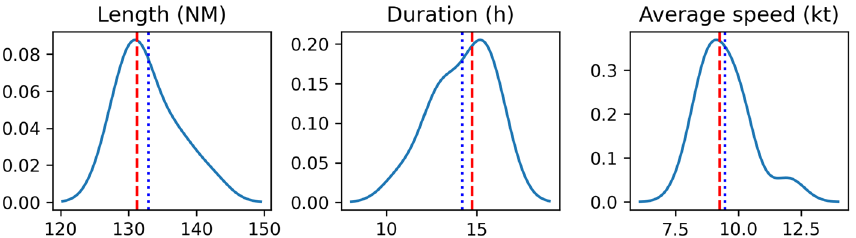
Figure 5. Distribution plots for voyage length, duration and average speed. Dashed vertical line represents median value and dotted line represents mean value.